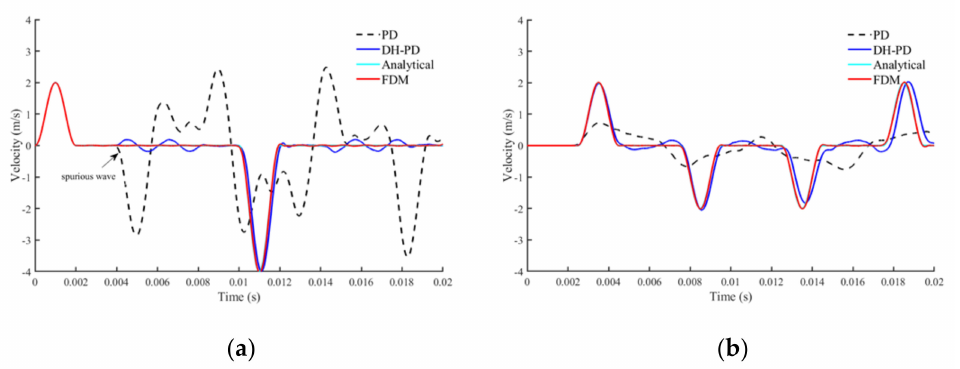
Figure 13. Time-velocity curves of analytical solution and numerical solution. ( a ) Velocity history at the free end of the bar. ( b ) Velocity history at the middle of the